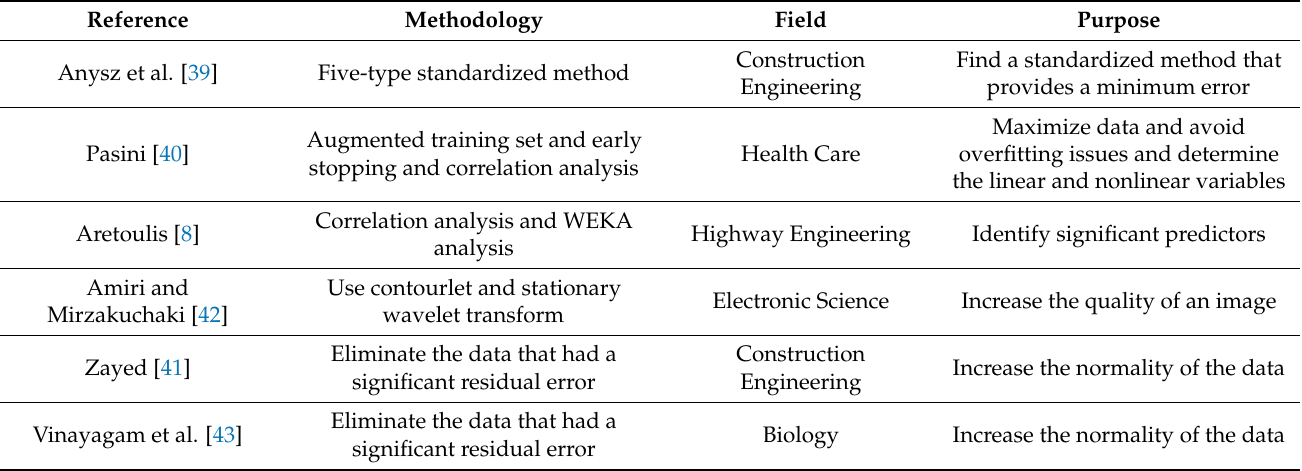
Table 2. Literature aimed at improving neural network performance to handle relatively little